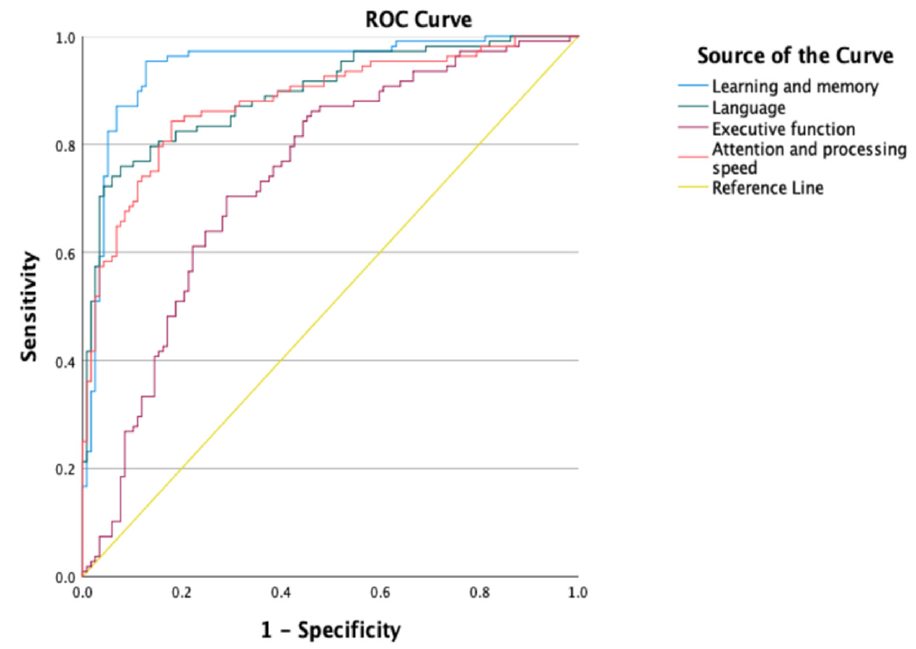
Figure 1. ROC curves representing different cognitive domains.